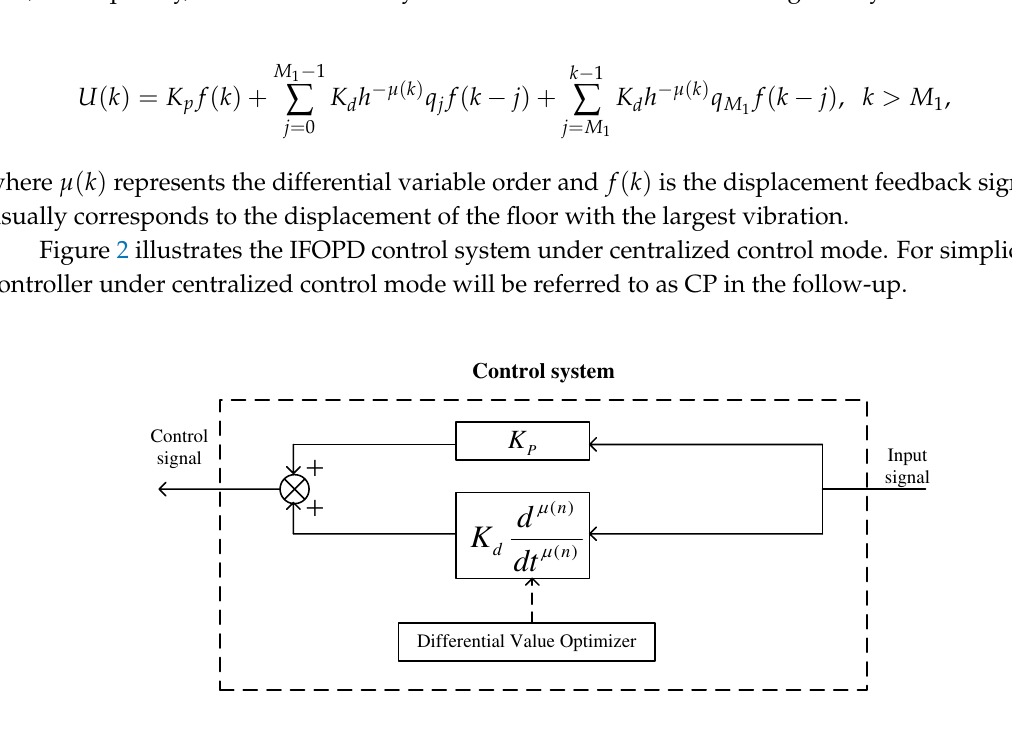
Figure 2. Control system using the IFOPD under a centralized control